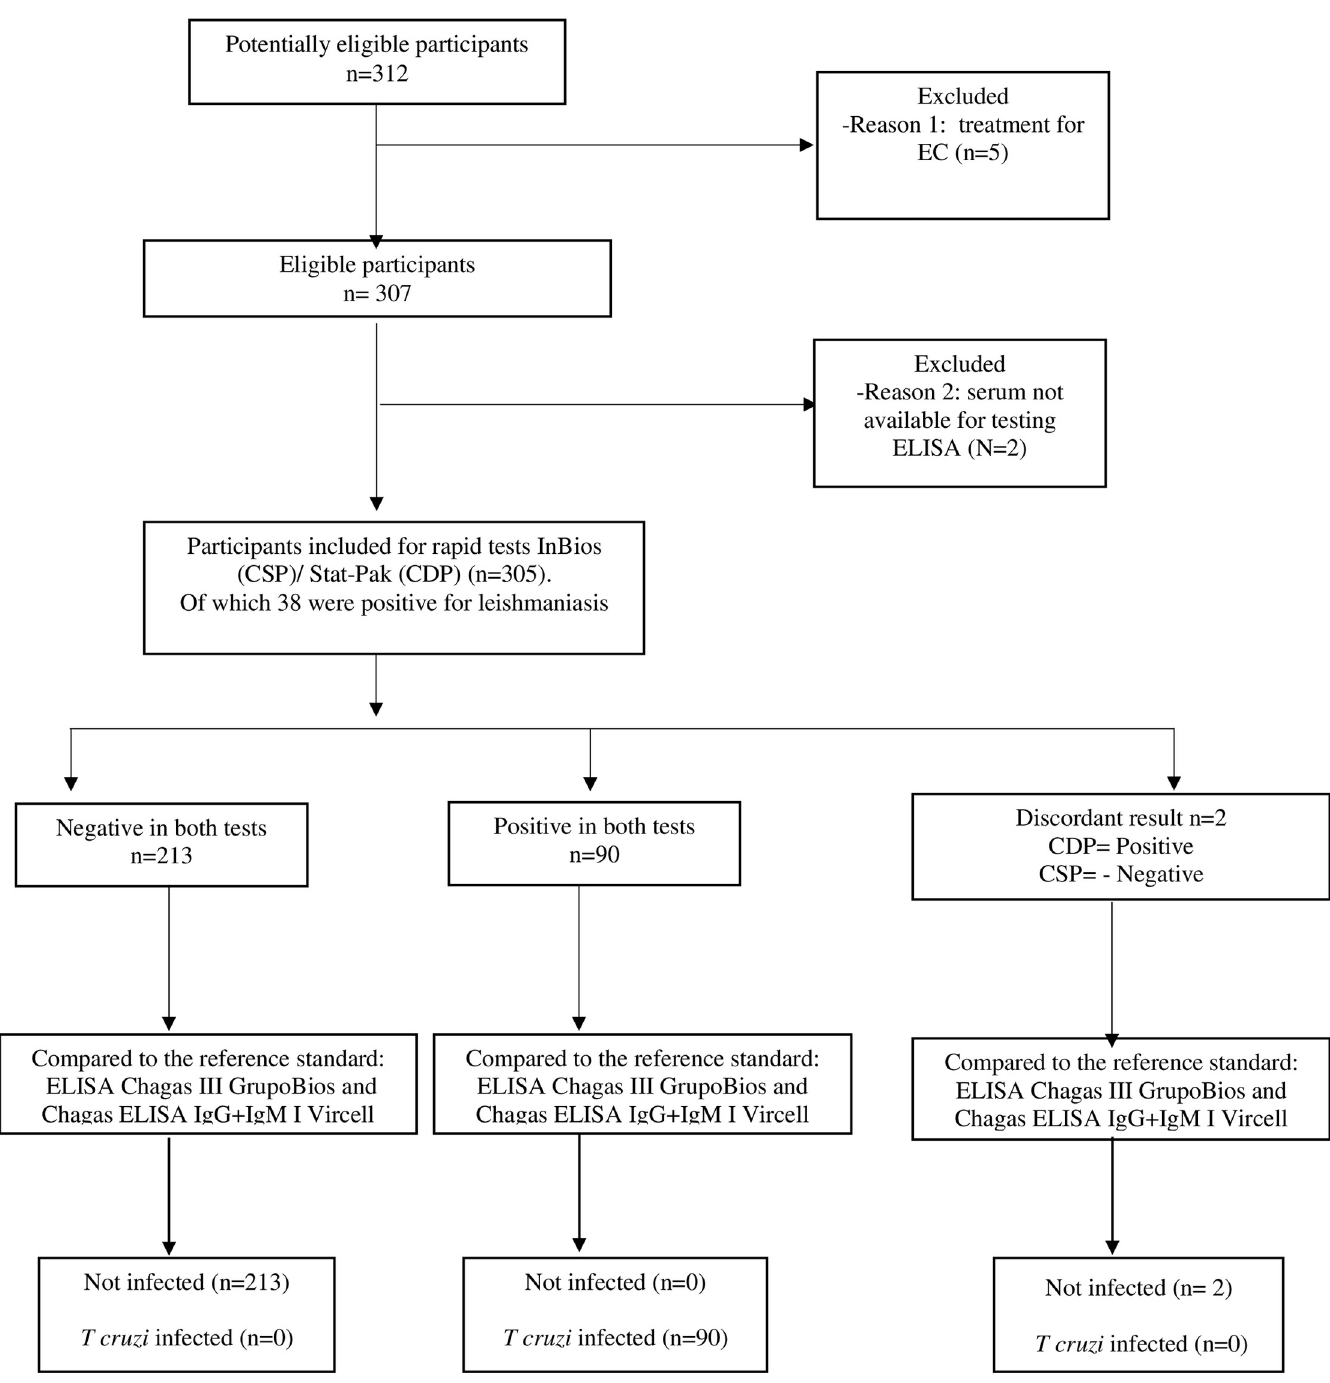
Fig 1. Flowchart of study participants and RDT and ELISA test